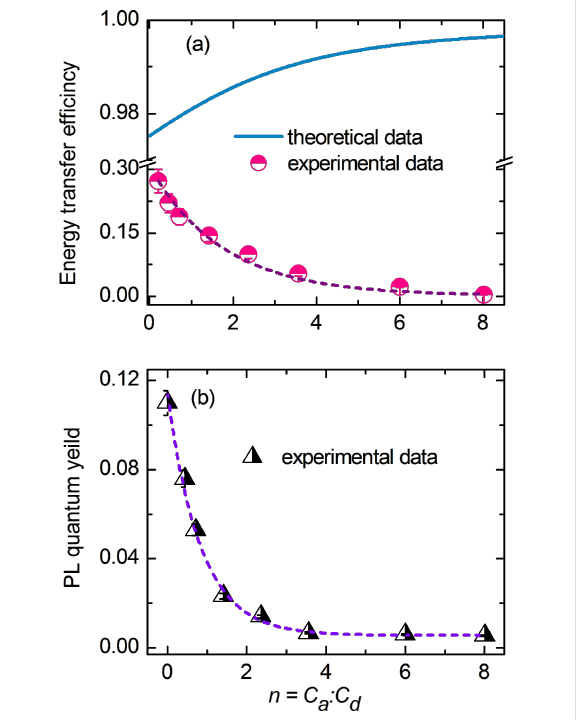
Figure 2: (a) Energy transfer efficiency calculated from experimental and theoretical data using Equation 8 and Equation 6, respectively. (b) QY of directly excited PL of the PcS z molecules calculated using Equation 8 in QD/PcS z complexes as a function of the relative acceptor concentration n . Dashed lines are to guide the